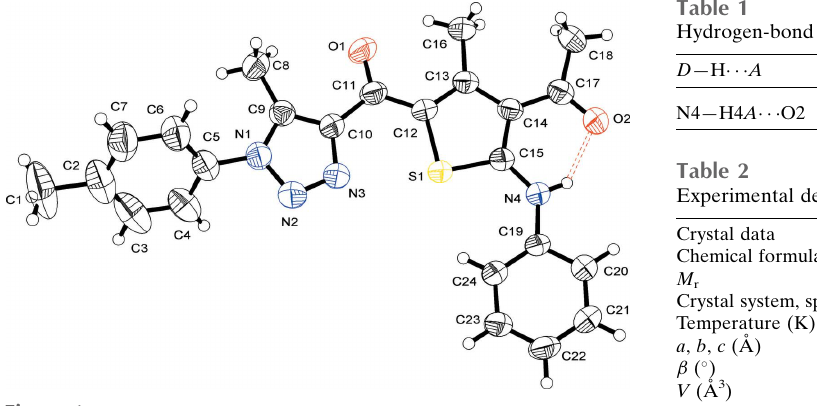
Figure 1 The molecular structure of the title compound, showing 50% probability displacement ellipsoids and the intramolecular N—H (cid:3)(cid:3)(cid:3) O hydrogen bond (dashed